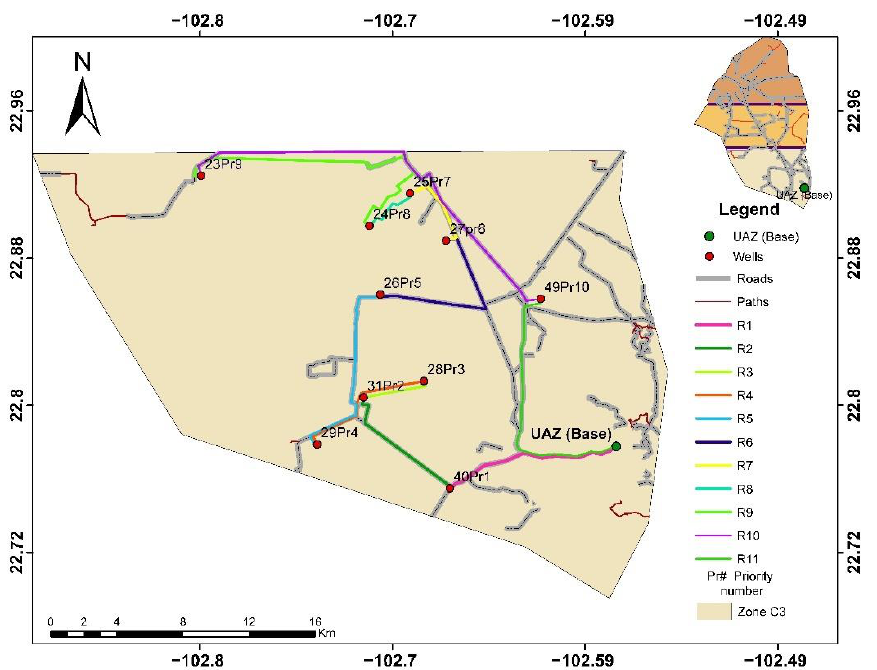
Figure 8. Monitoring wells with their visit priorities for Zone C3; the monitoring route begins and ends at the UAZ (Base).